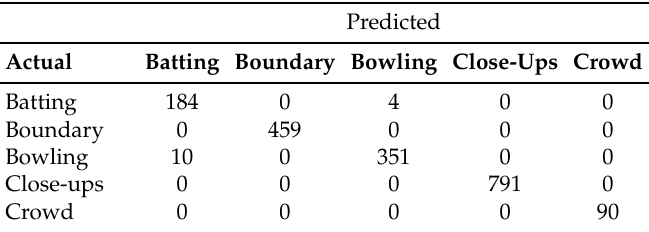
Figure 7. Video scene classification predicted vs. ground truth. Table 4. Confusion matrix (proposed model).